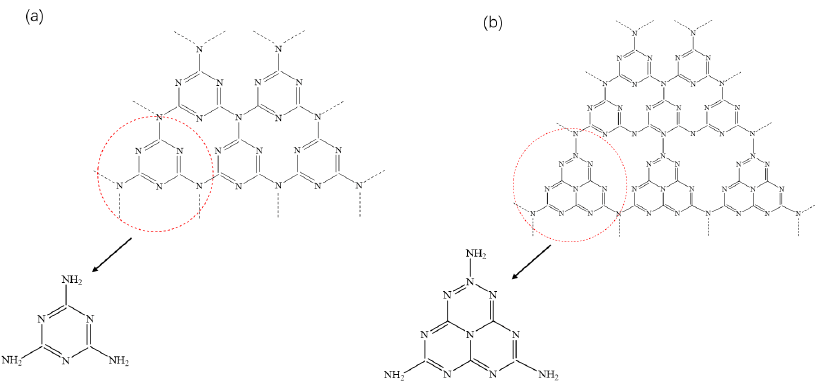
Figure 2. ( a ) Triazine ring unit of g-C 3 N 4 ; ( b ) The heptadazine ring unit of g-C 3 N 4 .